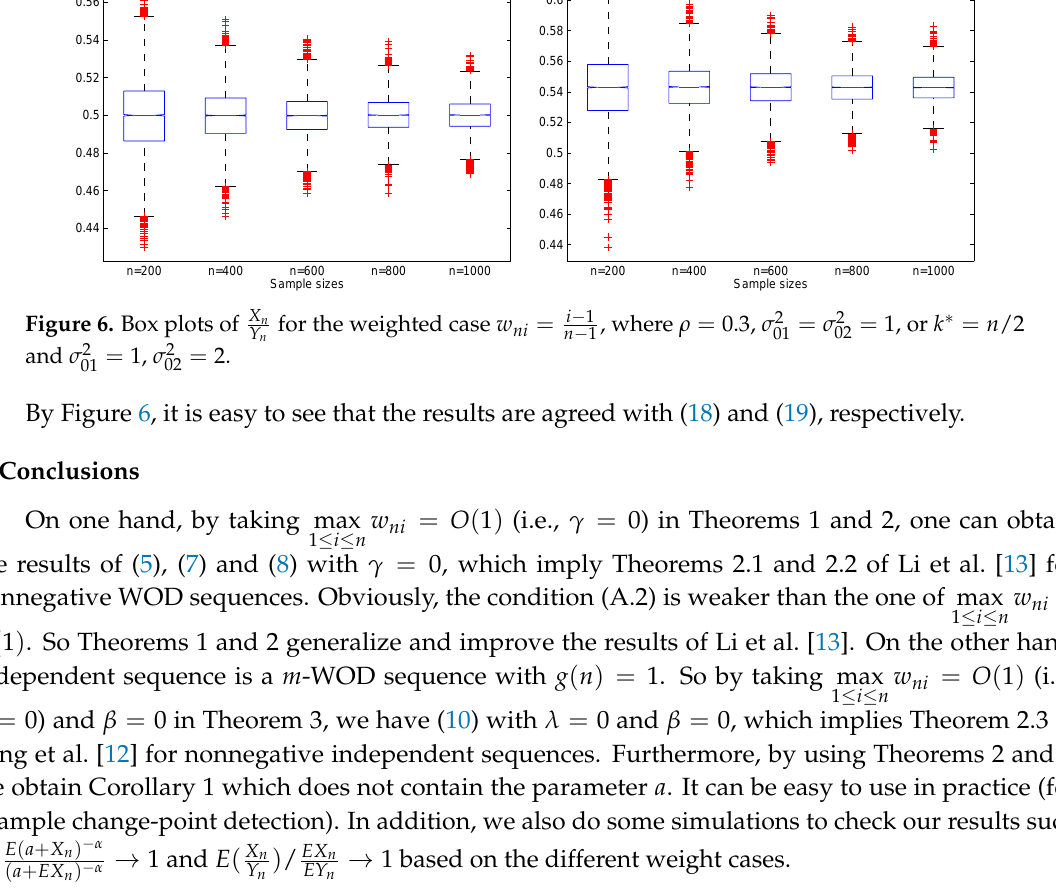
, where ρ = 0.3, σ 2 n − 1